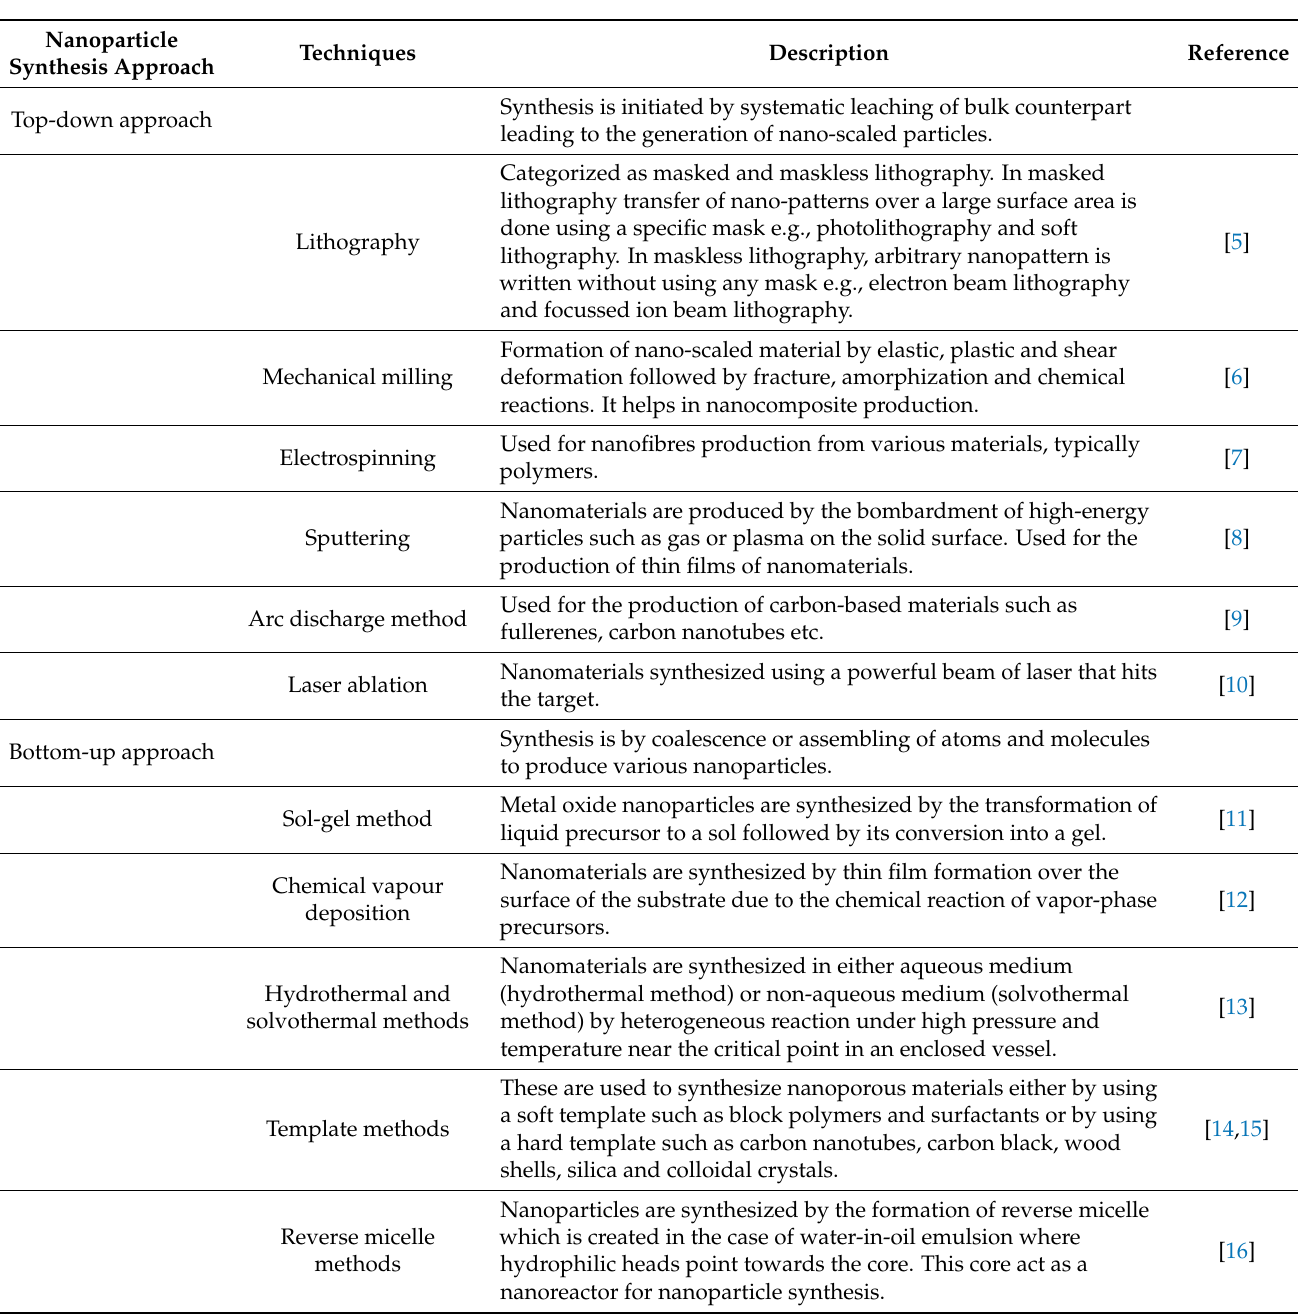
Table 1. Techniques used in the synthesis of